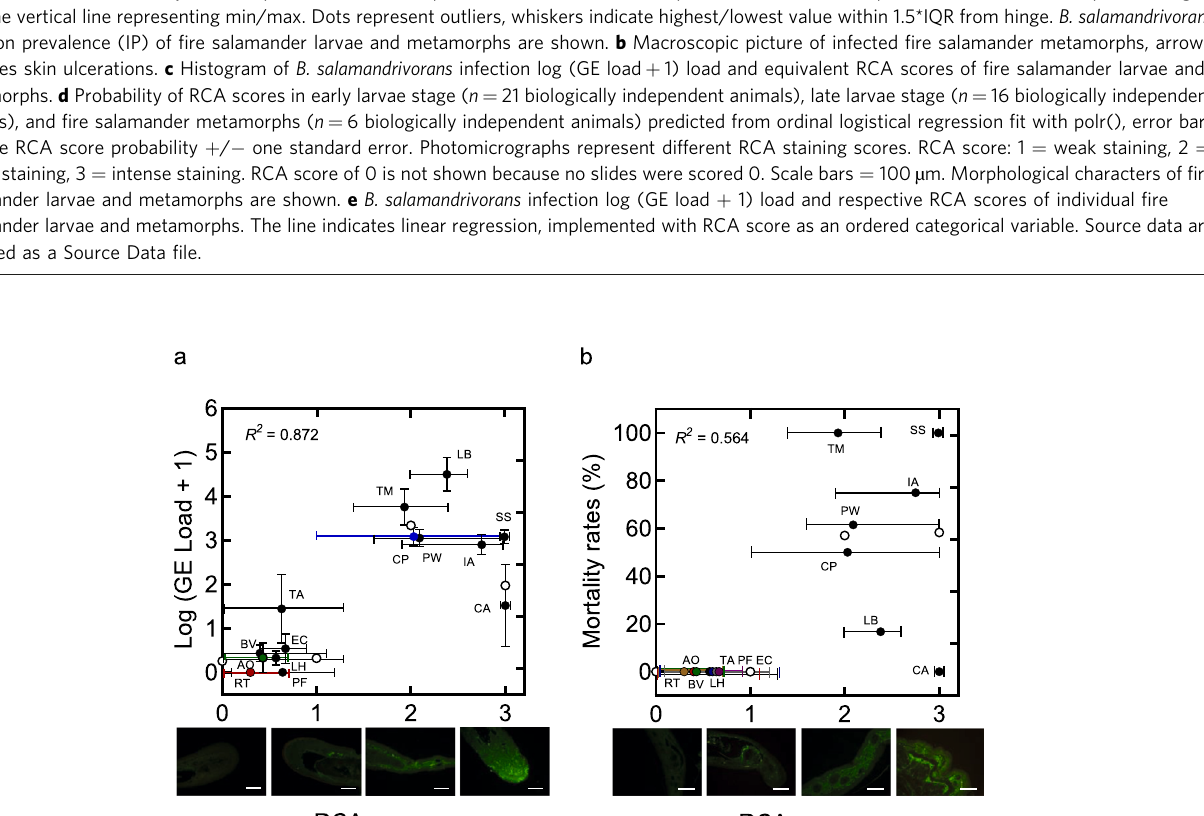
Fig. 5 Skin galactose staining predicts B. salamandrivorans infection intensity and survival probability. a Intensity of RCA staining in relation to B. salamandrivorans infection peak loads of different amphibian species. B. salamandrivorans infection peak loads are expressed in log (genomic equivalents (GE) load + 1). Vertical error bars indicate standard error of mean. b Intensity of RCA staining in relation to mortality rates of different amphibian species. a , b Horizontal error bars indicate minimum and maximum RCA scores, black and coloured dots represent the mean value overall. Linear regressions were performed using dummy variables for RCA scores. White dots represent the predicted values of infection peak loads and mortality rates for each RCA score generated by the regression model. R 2 indicates the coef fi cient of multiple determination in the regression model. RCA score: 0 = negative staining, 1 = weak staining, 2 = strong staining, 3 = intense staining. Photomicrographs represent different RCA staining scores. Scale bars = 100 µ m. Urodele species: LH = Lissotriton helveticus , PW = Pleurodeles waltl , LB = Lissotriton boscai , TA = Triturus anatolicus , TM = Triturus marmoratus , CP = Cynops pyrrhogaster , IA = Ichthyosaura alpestris , SS = Salamandra Salamandra and CA = Calotriton asper . Anuran species: AO = Alytes obstetricans , RT = Rana temporaria , BV = Bombina variegata , PF = Pelobates fuscus and EC = Epidalea calamita . Number of biologically independent animals used for RCA staining: LH ( n = 13), PW ( n = 11), LB ( n = 3), TA ( n = 3), TM ( n = 3), CP ( n = 3), IA ( n = 12), SS ( n = 10), CA ( n = 10), AO ( n = 10), RT ( n = 10), BV ( n = 5), PF ( n = 5) and EC ( n = 5). Number of biologically independent animals in infection trials: LH ( n = 23), PW ( n = 13), LB ( n = 6), TA ( n = 6), TM ( n = 6), CP ( n = 8), IA ( n = 20), SS ( n = 26), CA ( n = 5), AO ( n = 13), RT ( n = 5), BV ( n = 4), PF ( n = 5) and EC ( n = 5). Source data are provided as a Source Data fi